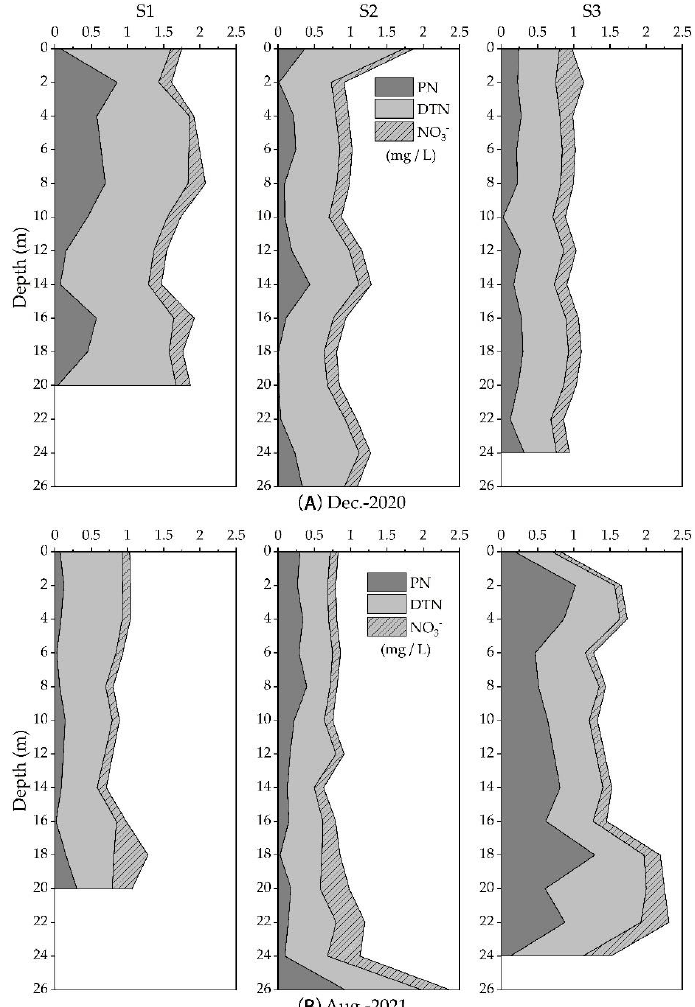
Figure 12. Nitrogen composition accumulation diagram in December 2020 and August 2021.